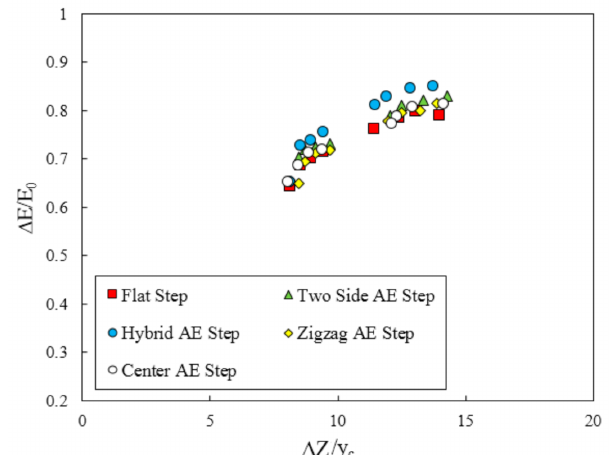
Figure 13. The rate of energy dissipation on flat with appendance elements (AE) on steps ver- sus ( ∆ Z/y c